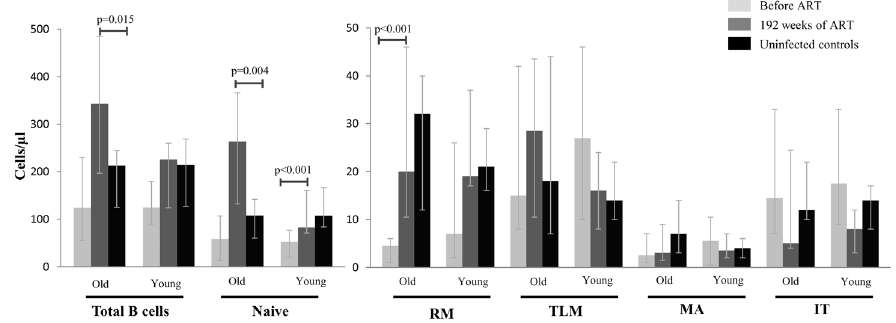
Figure 1. Absolute B cell phenotype counts before and after antiretroviral therapy. Changes in absolute B cell count and B cell subset counts at baseline before ART (light grey) and after 192 weeks of ART (dark grey) compared to their age-matched controls (black) in older and younger groups. Only the significant P-values are marked. Bars represent median; error bars represent interquartile ranges. RM: resting memory, TLM: tissue like memory, MA: mature activated, IT: immature